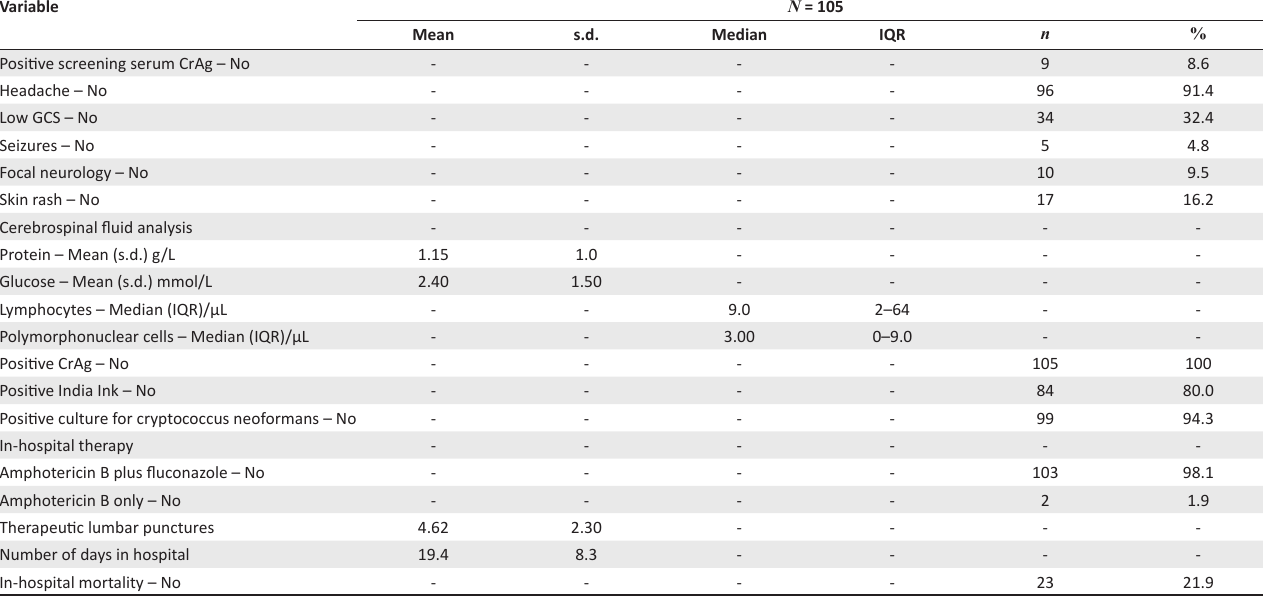
TABLE 2: Clinical features and cerebrospinal fluid